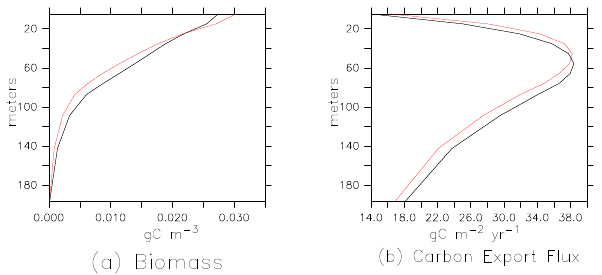
Figure 10. Globally averaged profile of (a) biomass in gCm − 3 and (b) carbon export flux in gCm − 2 yr − 1 . Black line shows data from the chl-only run, red line represents chl&CDM